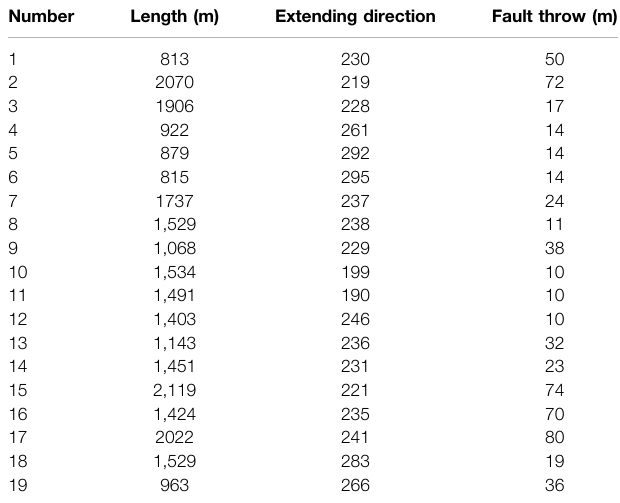
TABLE 1 | Summary of concealed fault